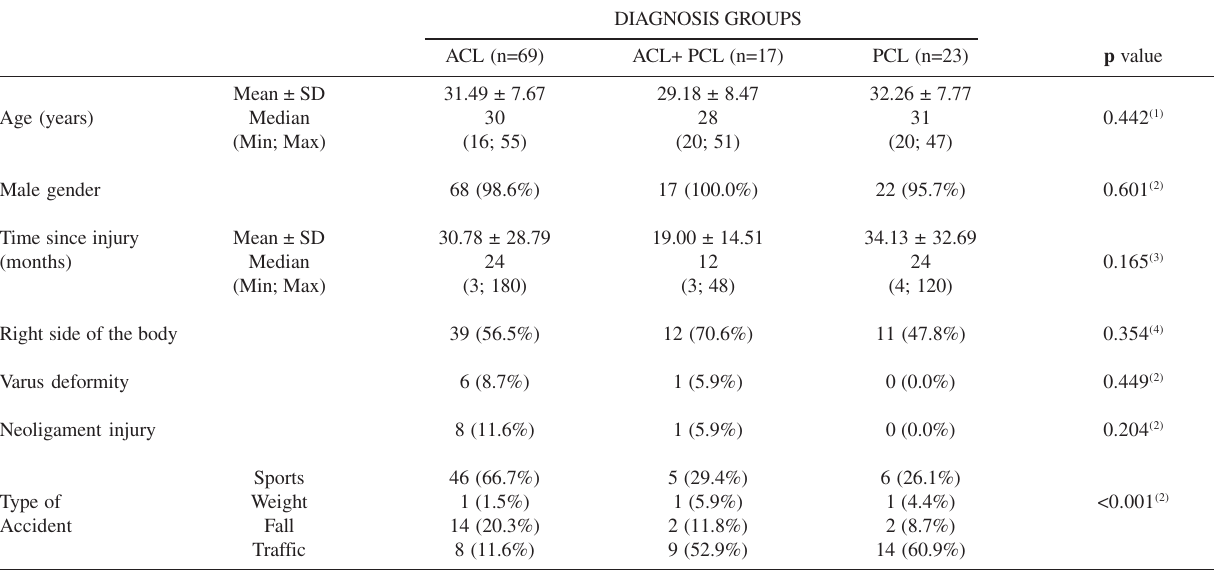
Table 1 - Comparison of diagnosis groups with other demographic and clinical